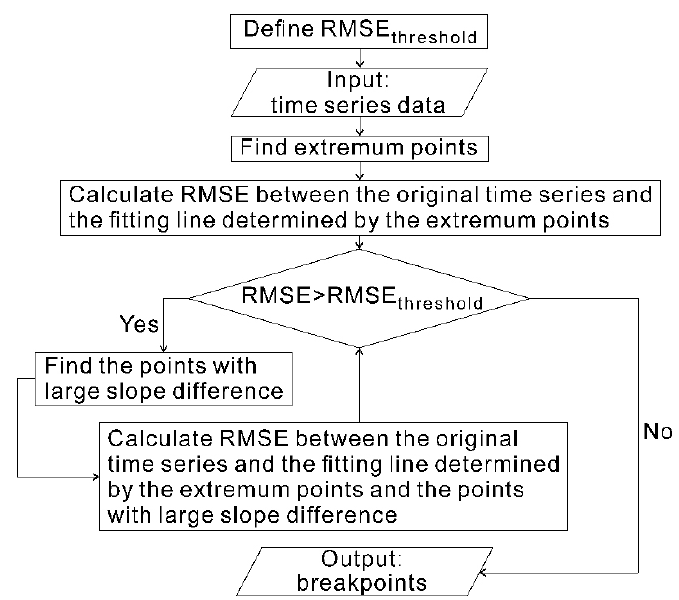
Figure 3. Procedure of determining breakpoints.